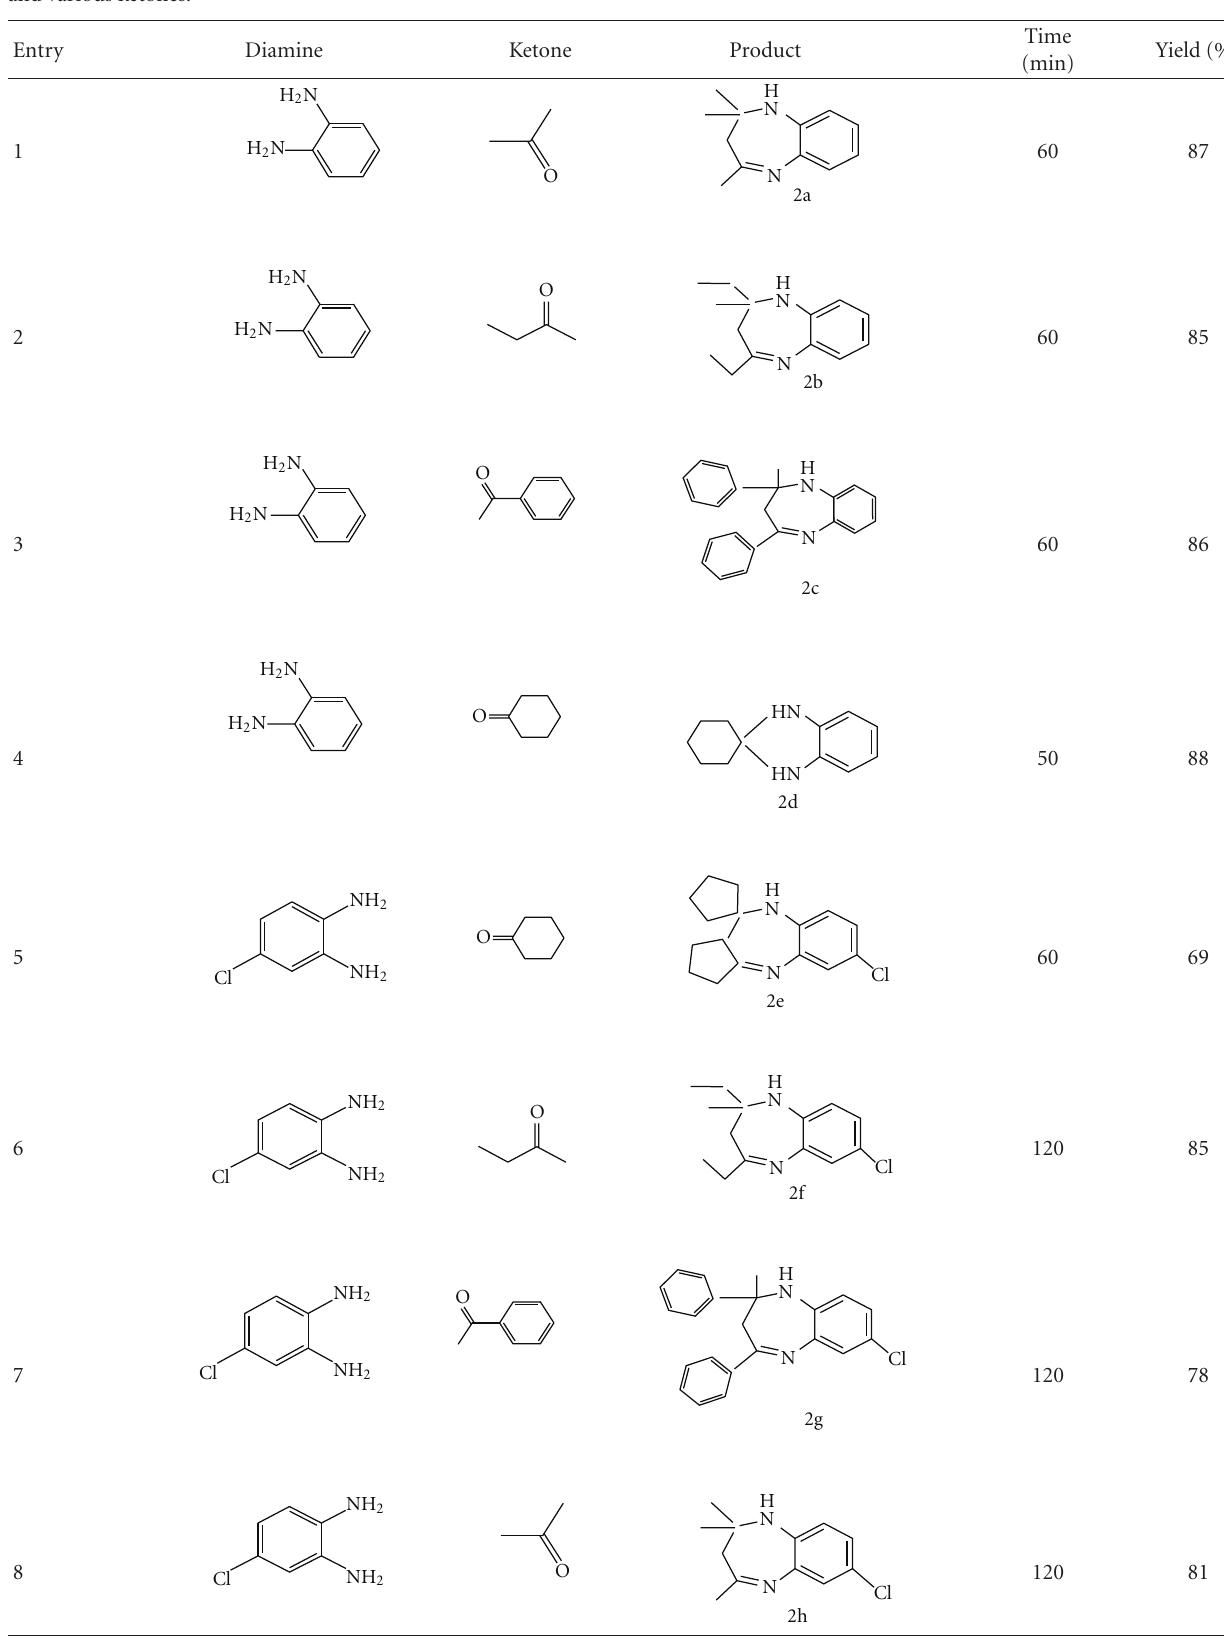
Table 2: Synthesis of 1,5-benzodiazepines and its derivatives using H-MCM-22 through a condensation reaction between a series of OPDA and various